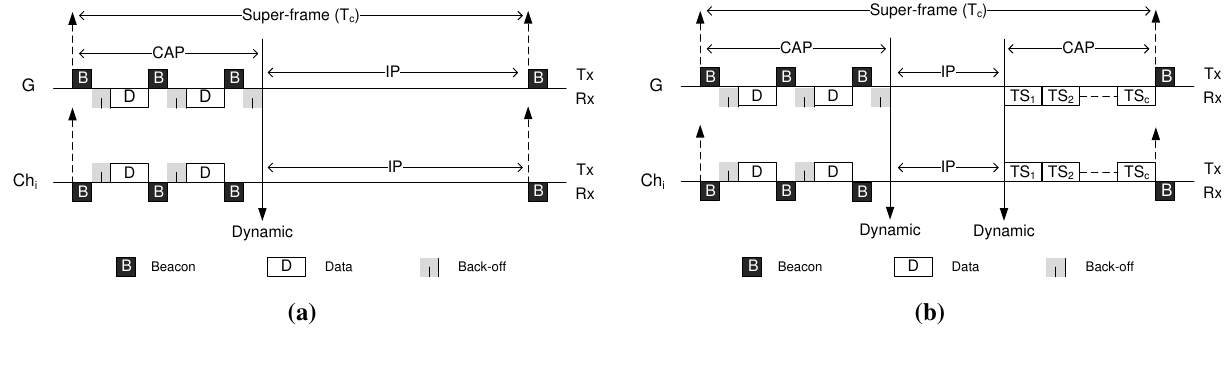
Figure 3. Cluster-head to gateway (Ch-to-G) communication snapshot: (a) Low load; (b) Moderate load; (c) High load; and (d)